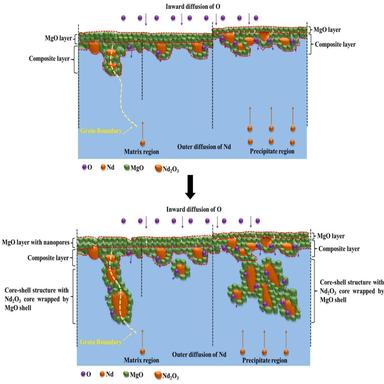
Schematic images showing the high-temperature oxidation process of ZM6 alloy.